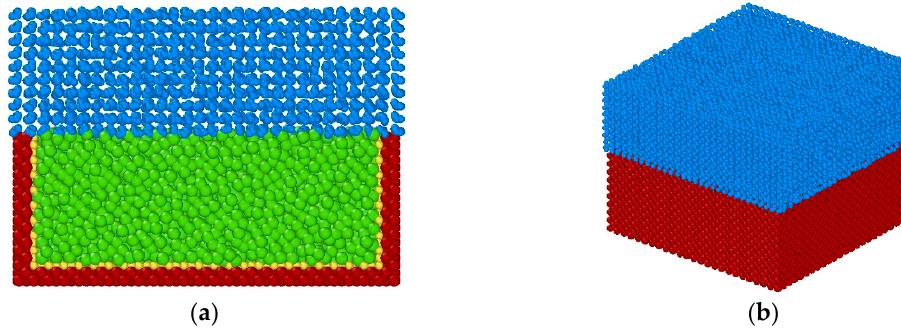
Figure 3. Molecular Dynamics Simulation Model of the Liquid-Assisted Laser Beam Micromachining (LA-LBMM) Process on Copper Substrate ( a ) Sectional view ( b ) 3-Dimensional view.